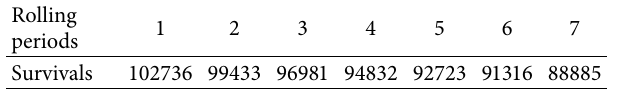
Table 13: Survivals in each period. Rolling periods